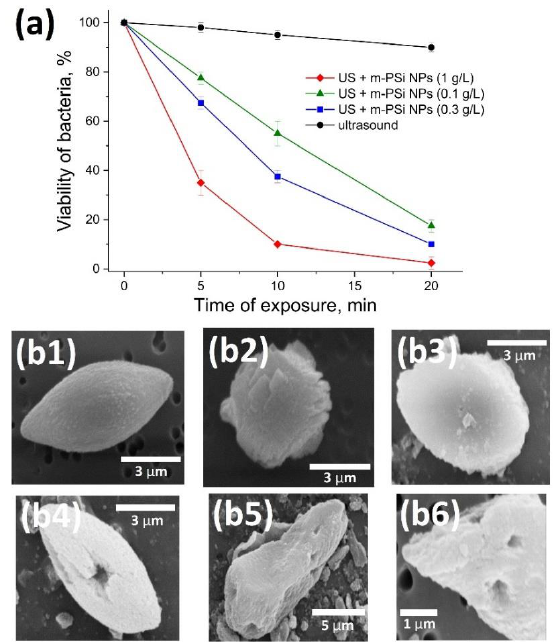
Figure 3. Antibacterial effect of combined action of ultrasound and m-PSi NPs. ( а ) Viability of Lactobacillus casei exposed to the ultrasound separately ( black line ) and in the presence of m-PSi NPs at a concentration of 0.1 ( green line ), 0.3 ( blue line ), and 1 ( red line ) g/L calculated as a number of live bacteria relative to their number in the reference colony corresponding to zero particle concentration. ( b ) Microscopic images of Lactobacillus casei : ( b1 ) as-grown, ( b2 ) after exposure to ultrasound, ( b3 ) incubated with m-PSi NPs, ( b4 – b6 ) after exposure to ultrasound in the presence of m-PSi NPs at the concentration of 1 mg/mL.